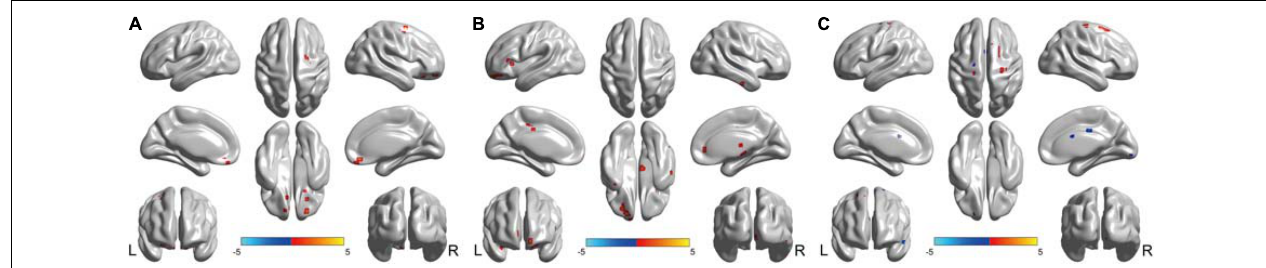
FIGURE 2 | Brain regions showed fALFF differences between every pair of groups with post hoc t -tests. (A) Brain regions showed fALFF differences between left Bell’s palsy and control groups. Compared with control group, left Bell’s palsy group showed significantly increased fALFF values in the bilateral rectus, left ORBsup, right ORBmid, right SFG, right PreCG, and right putamen. (B) Brain regions showed fALFF differences between right Bell’s palsy and control groups. Compared with control group, right Bell’s palsy group showed significantly increased fALFF values in the right ITG, right ORBinf, left ORBmid, left ORBsup, left TPOsup, left caudate, bilateral ACC, left IFGtriang, bilateral MCC, and left IPL. (C) Brain regions showed fALFF differences between left and right Bell’s palsy groups. Compared with right Bell’s palsy group, left Bell’s palsy group showed significantly decreased fALFF values in the left TPOsup, right SMG, bilateral MCC, left SFG, and left PreCG; the left Bell’s palsy showed significantly increased fALFF values were the right SFG and PreCG. TPOsup, superior temporal gyrus in the temporal pole; SMG, supramarginal; MCC, middle cingulate cortex; SFG, superior frontal gyrus; PreCG, precentral gyrus; ORBsup, orbital part of superior frontal gyrus; ORBmid, orbital part of middle frontal gyrus; ITG, inferior temporal gyrus; ORBinf, orbital part of Inferior frontal gyrus; ACC, anterior cingulate cortex; IFGtriang, triangular part of inferior frontal gyrus; IPL, left inferior parietal lobule.